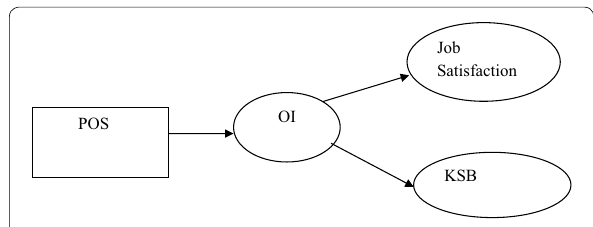
Fig. 1 Proposed conceptual framework